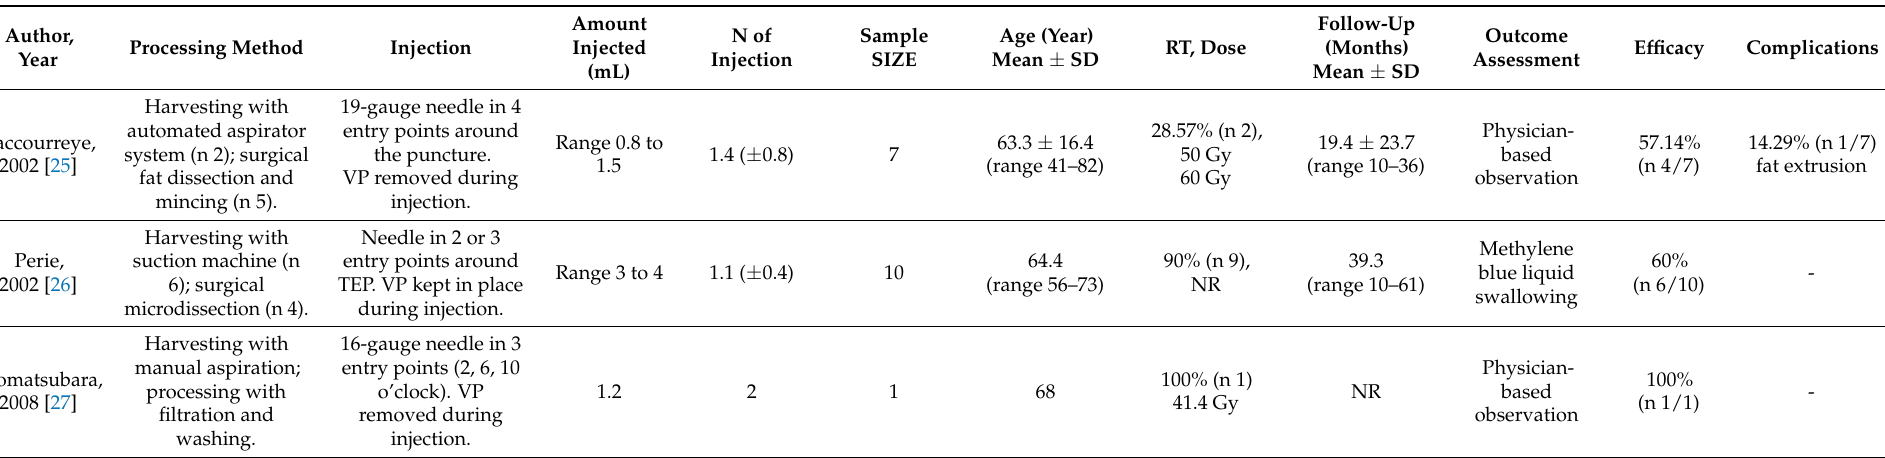
Table 2. Review of the literature on the use of adipose stem cell-based therapies to manage tracheoesophageal puncture